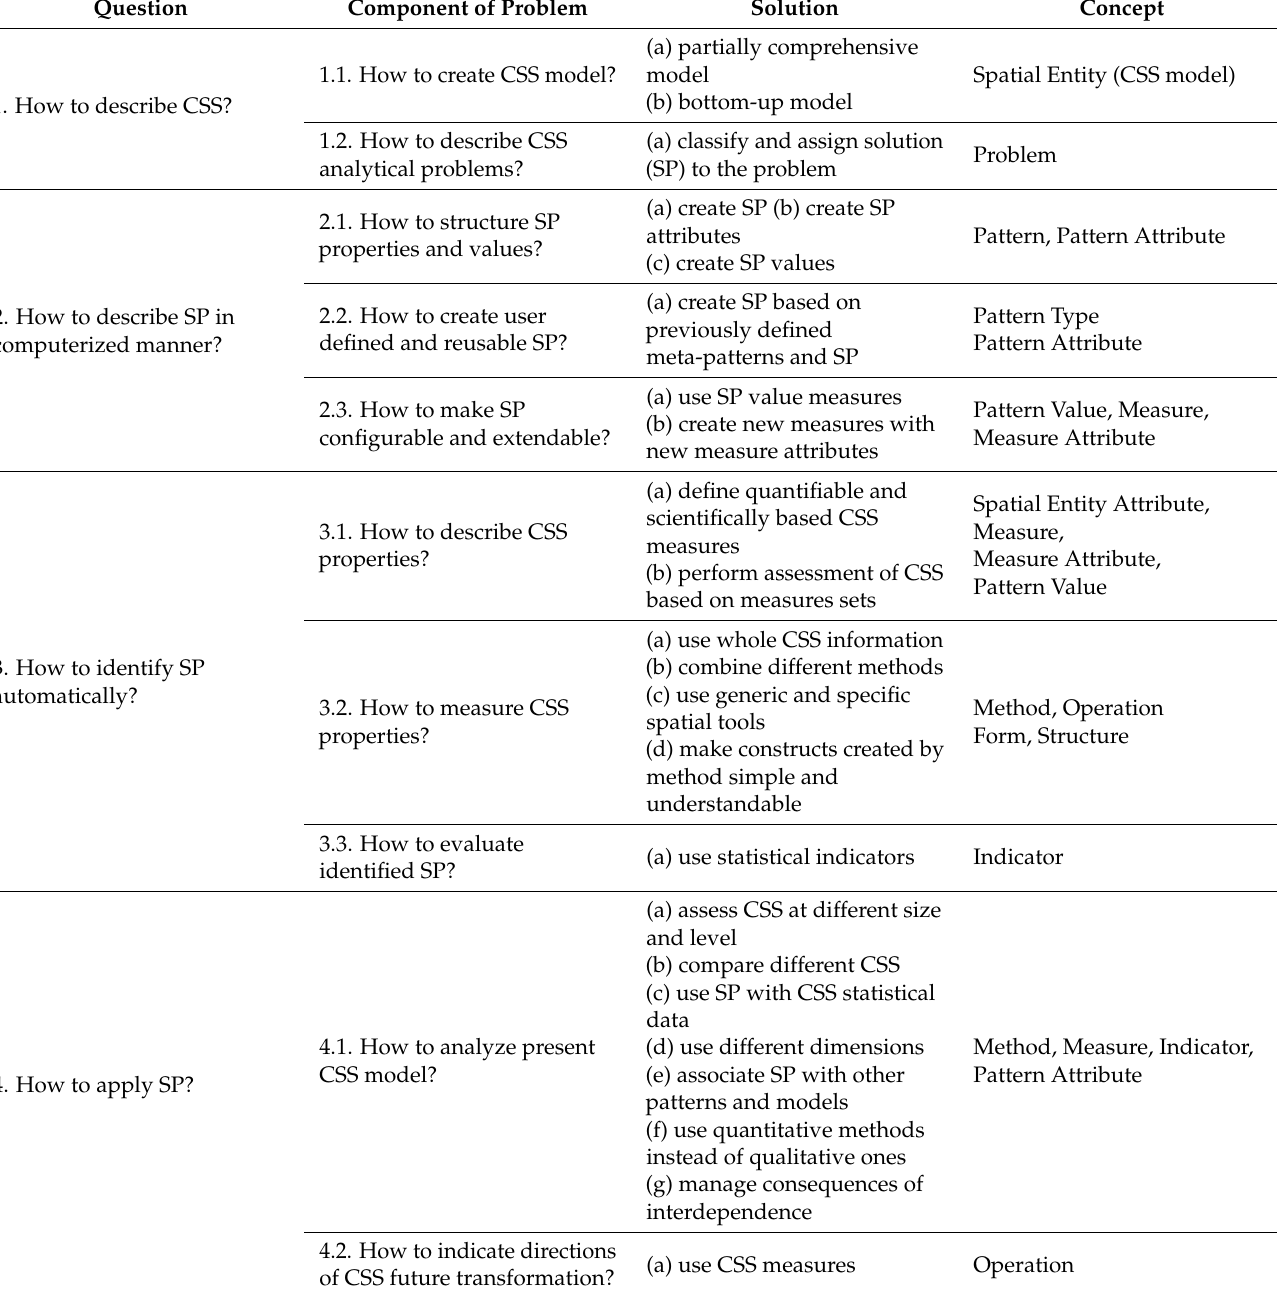
Table 2. Composition of SPDIAM problems and